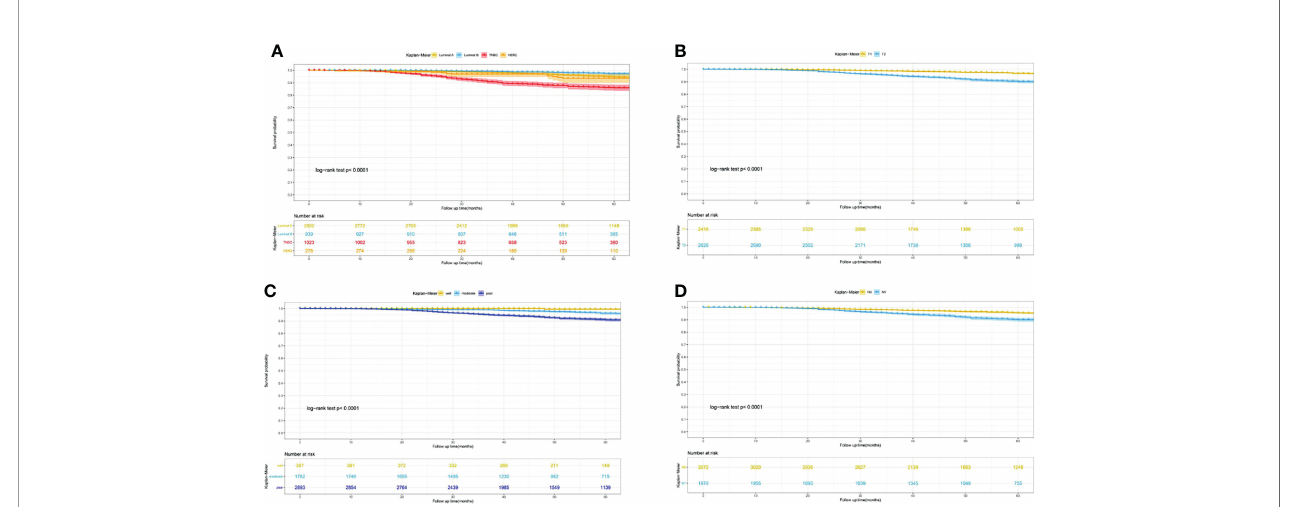
FIGURE 1 | Kaplan-Meier curves for predicting the 3-, 5- year CSS of young women with early-stage breast cancer. (A) different molecular subtype; (B) tumor size; (C) differentiation grade; (D) lymph node status. CSS, cancer-speci fi c survival.